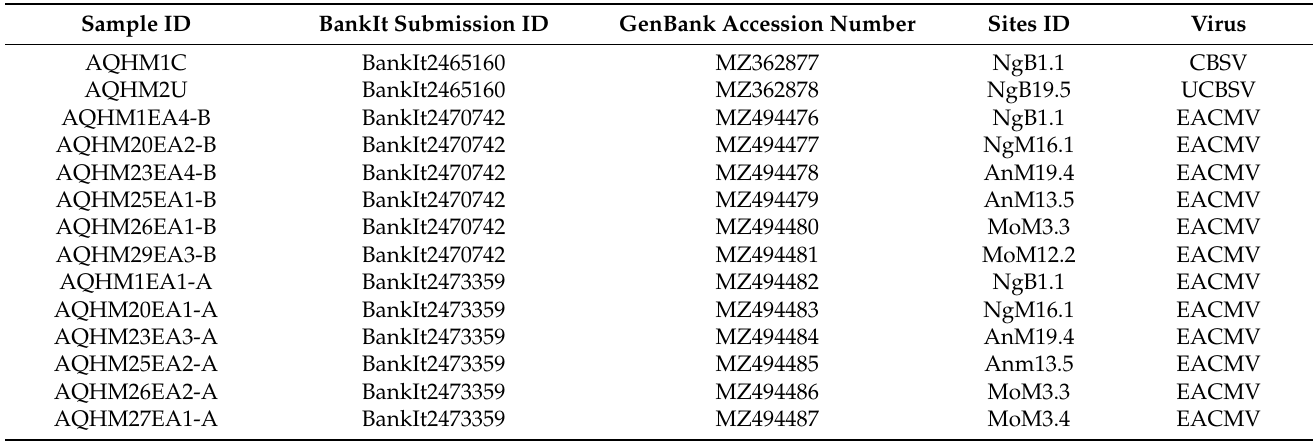
Table 4. Full genome sequences of cassava brown streak ipomoviruses and cassava mosaic gemi- niviruses isolated from different locations in Comoros, July 2019.